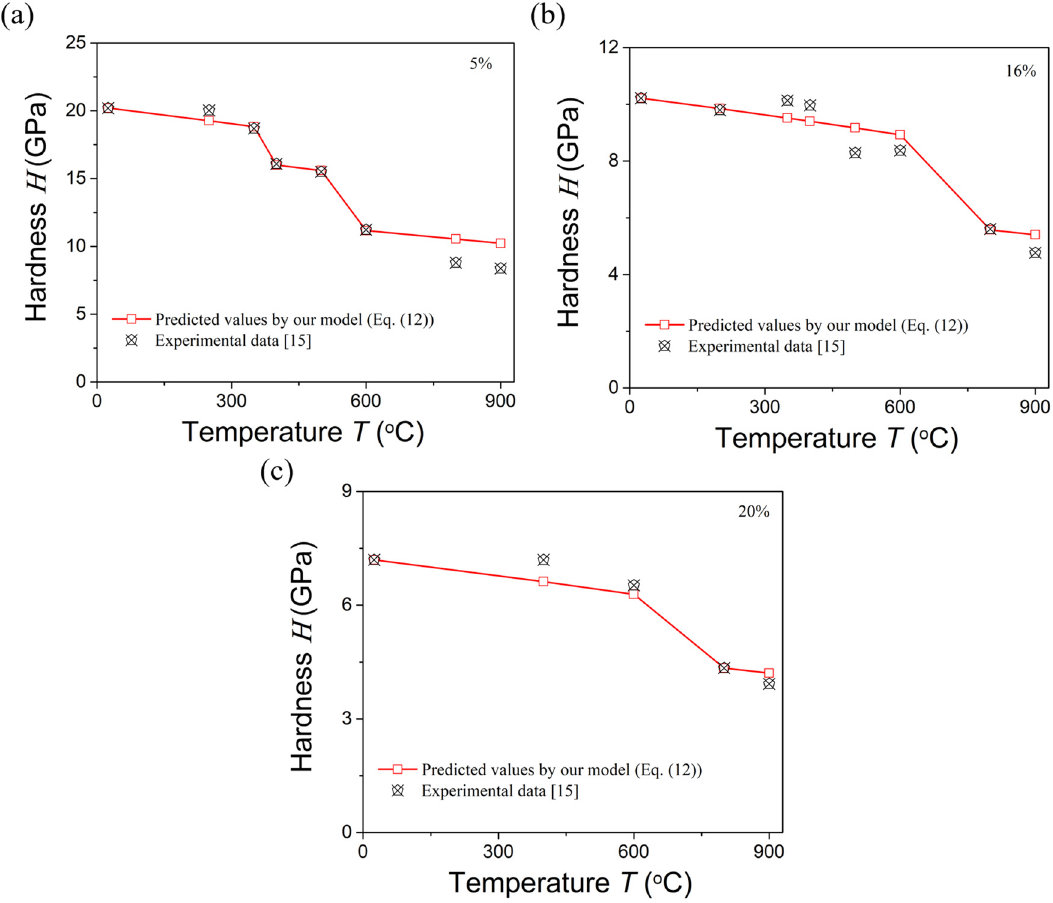
Figure 5: Comparison between the model - predicted and measured hardness of the porous SiC ceramics with di ff erent porosity at high temperature: ( a ) 5%, ( b ) 16%, ( c )